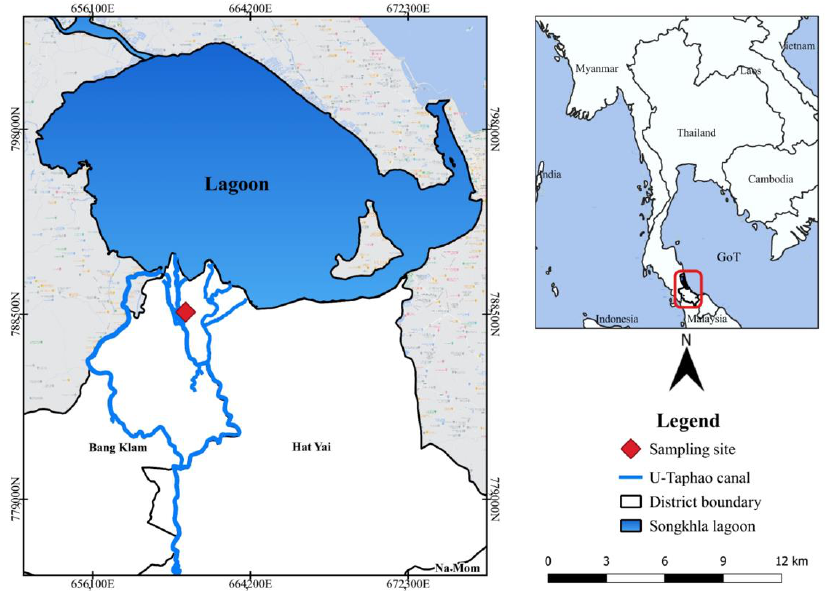
Figure 1 . Sampling site at U - Taphao canal, a river flowing to Songkhla Lagoon, Southern Thailand . Figure 1. Sampling site at U-Taphao canal, a river flowing to Songkhla Lagoon, Southern